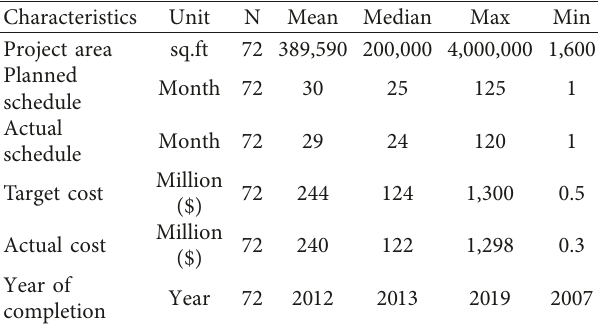
Table 1: Descriptive statistics of collected data.